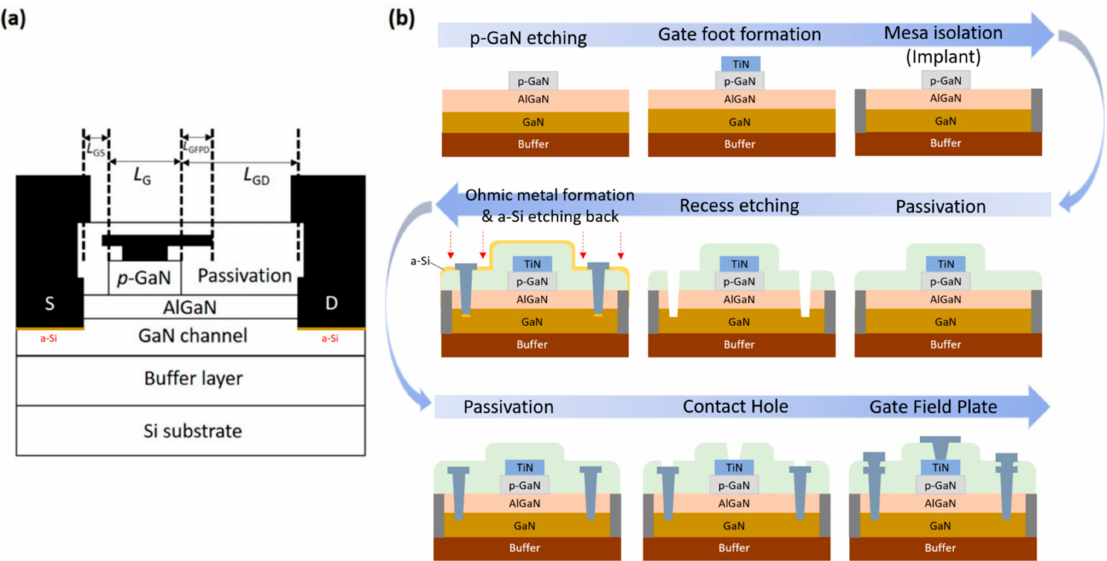
Figure 1. ( a ) Schematic cross-section of the GaN-based HEMT device structure. ( b ) Device process flow.